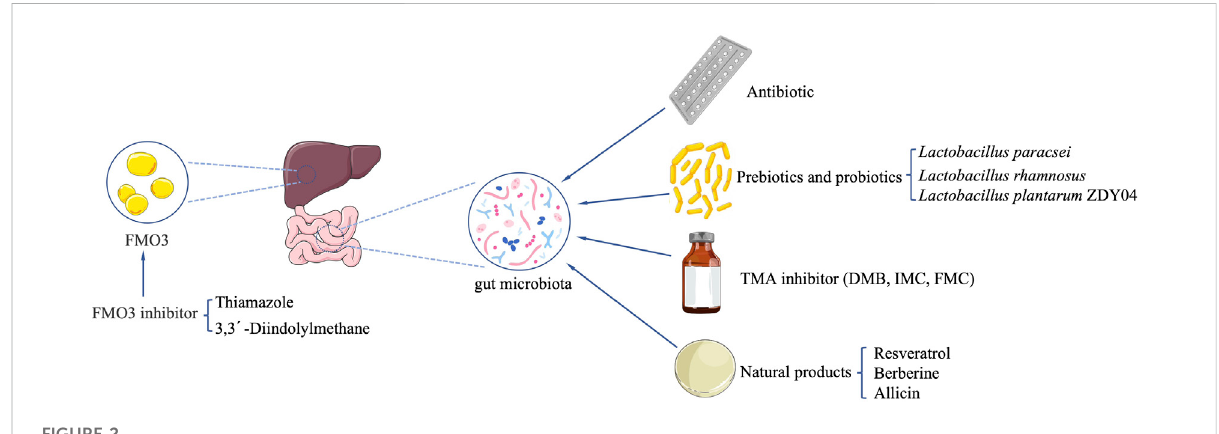
FIGURE 2 Potential strategies to reduce TMAO formation in vivo